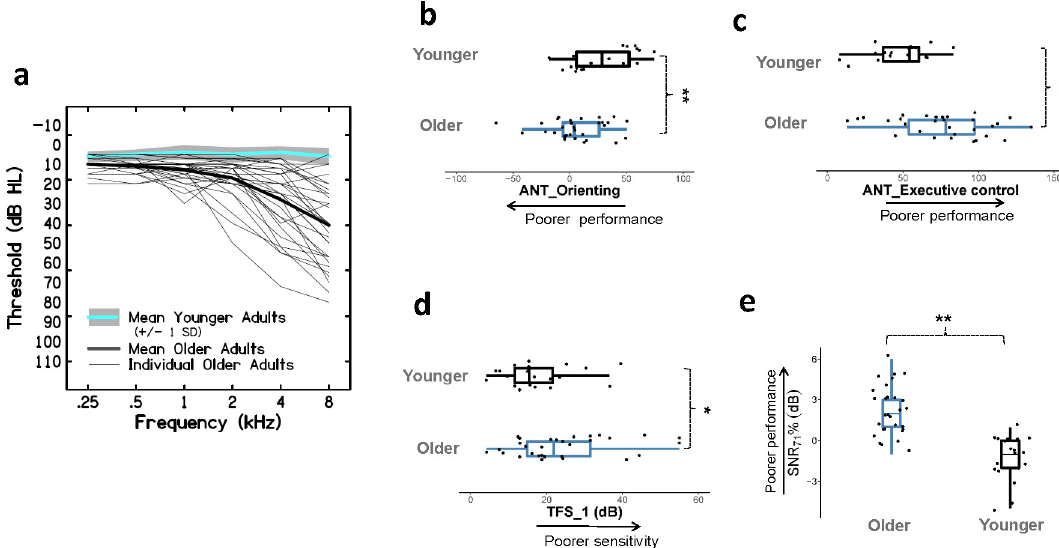
Fig 2. Behavioral measures. a . Pure-tone audiograms averaged between ears (L/R) for the Older and Younger participants. b , c . Performance on the attention network test (ANT): (c) Orienting network, (d) Executive control network. d . Sensitivity to TFS cues, using center frequency = 2.2 kHz in both groups. Poor performance on this task indicated poor temporal processing abilities. e . SNR 71% in the two groups measured in the digits-in-noise recognition task for the degraded listening condition. Poor performance on this task indicates poor visual sectional abilities. � p < 0 . 05 �� p < 0 . 01 .